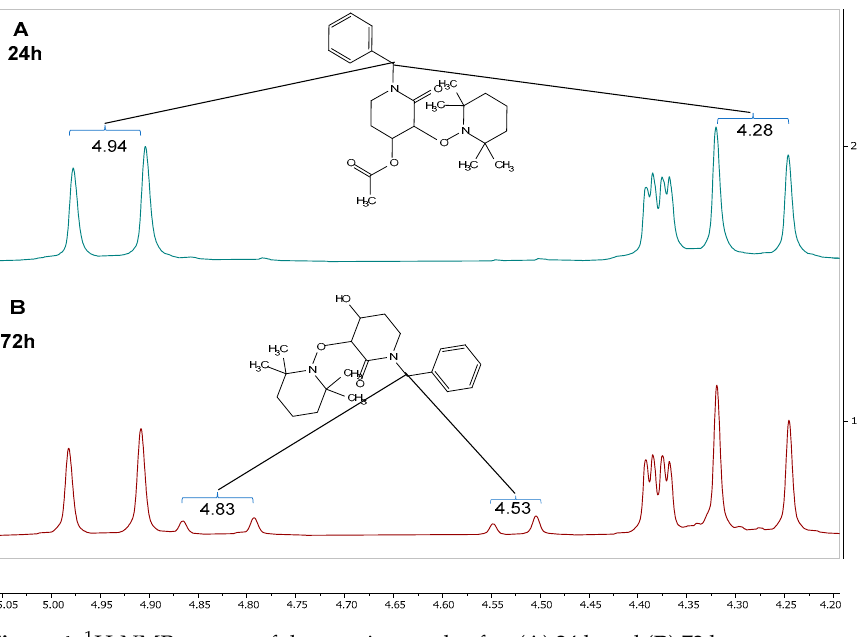
Figure 4. 1 H-NMR spectra of the reaction crude after ( A ) 24 h and ( B ) 72 h.